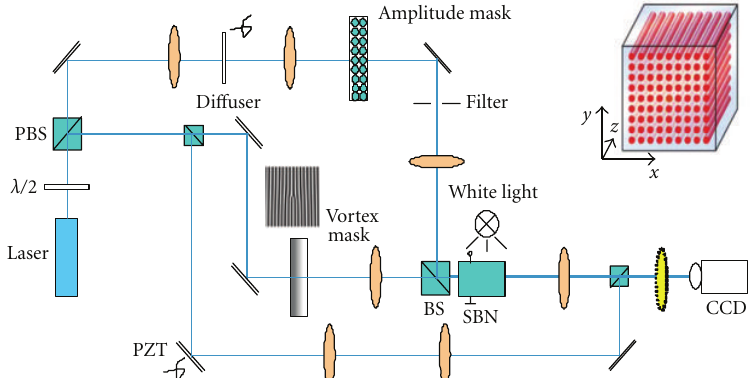
Figure 1: Experimental setup for optical induction of photonic lattices in a biased photorefractive crystal by amplitude modulation of a partially coherent beam. PBS: polarizing beam splitter; SBN: strontium barium niobate. Top path is the lattice-inducing beam, the middle path is the probing vortex beam, and the bottom path is the reference beam. The top right insert illustrates the scheme of induced waveguide arrays in the otherwise uniform SBN nonlinear